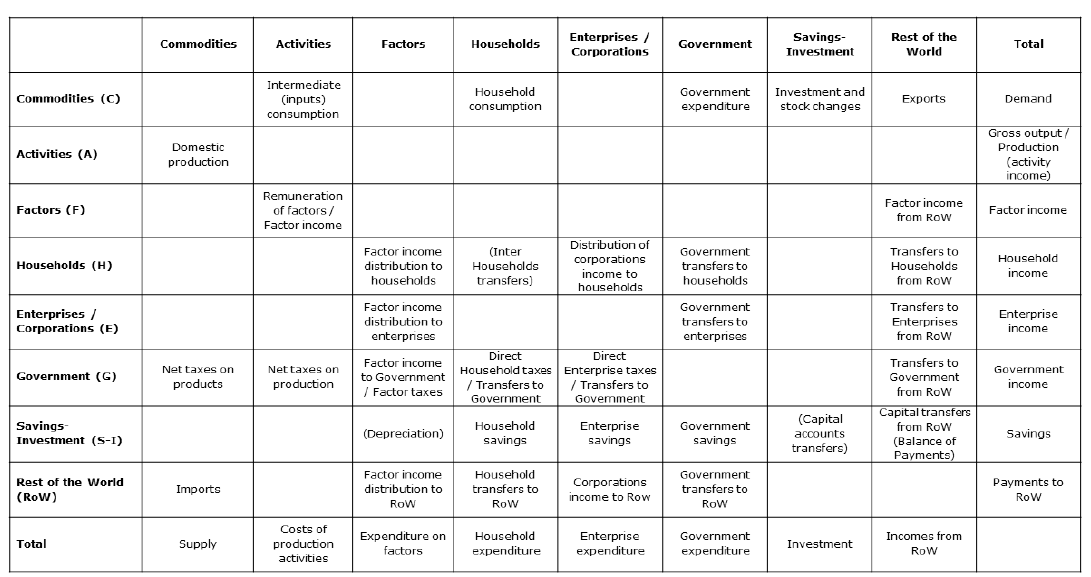
Figure 1. Standard structure of a Social Accounting Matrix (SAM). Source: Authors’ own based on Mainar et al. (2018).